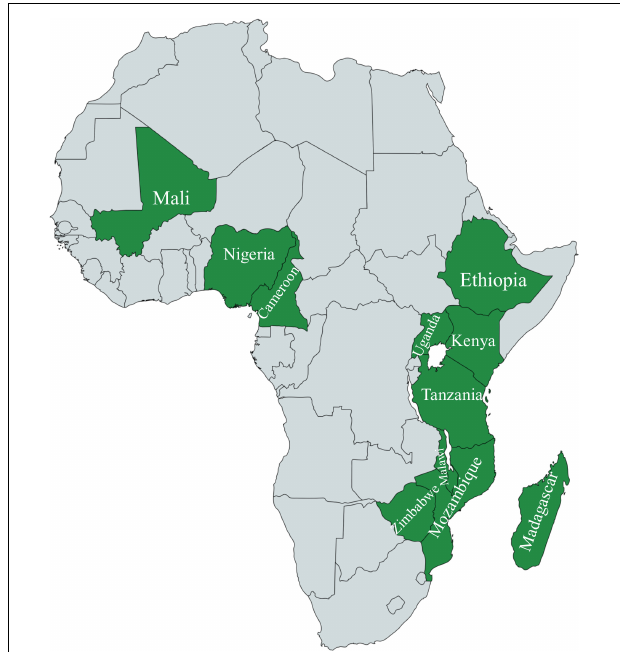
FIGURE 1 | Countries from which data were collected on the African Continent. Created with MapChart